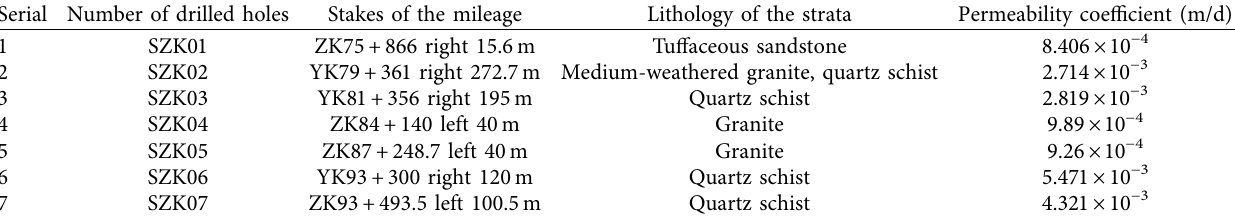
Serial Number of drilled holes